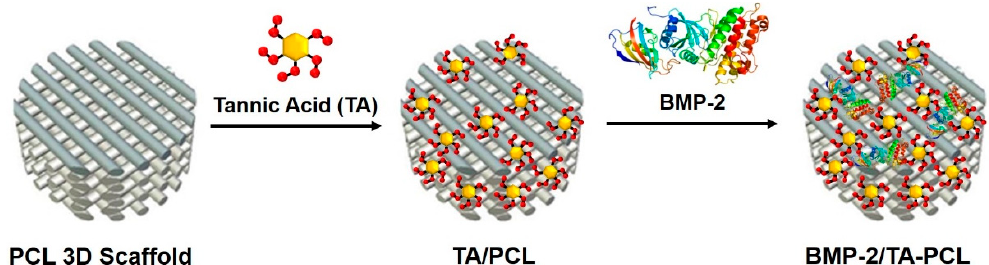
Figure 1. Schematic illustration for the preparation of the bone morphogenic protein-2 (BMP-2)/tannic acid (TA)/three-dimensional (3D) polycaprolactone (PCL) scaffold.